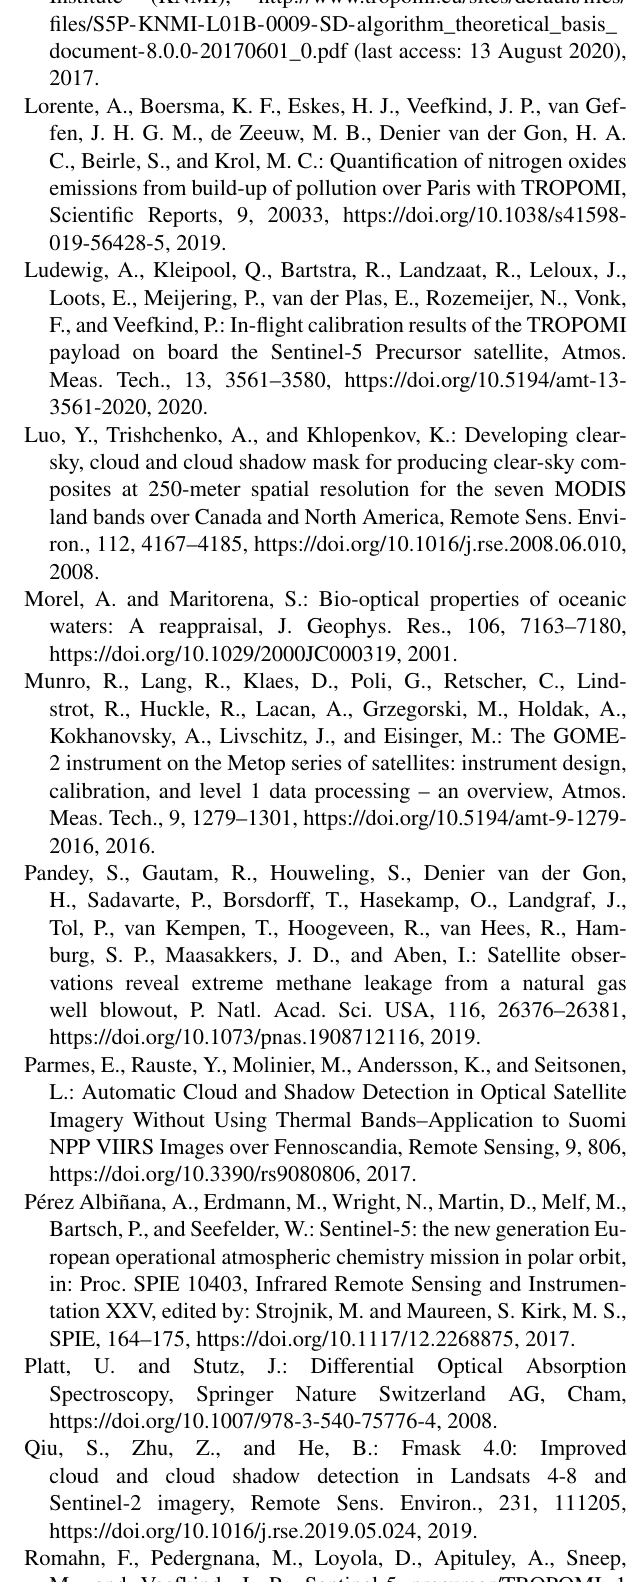
Algorithm theoretical basis document for the